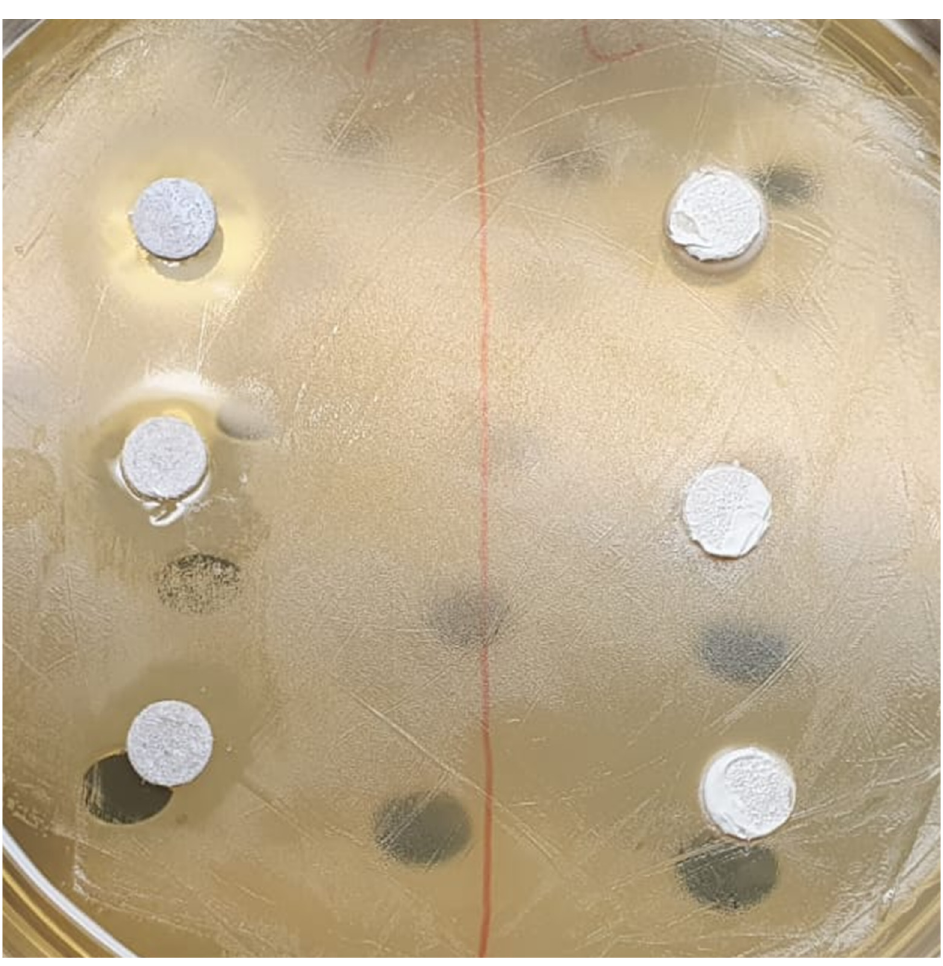
Figure 1. All materials were prepared according to manufacturers’ recommendations and collected on glass